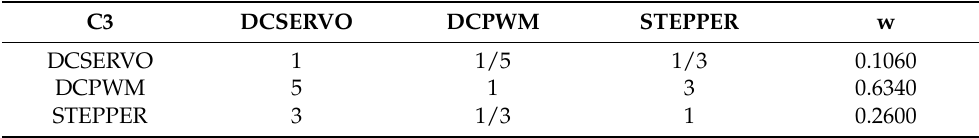
Table 6. Pairwise comparison of the actuation solutions (criterion C3).